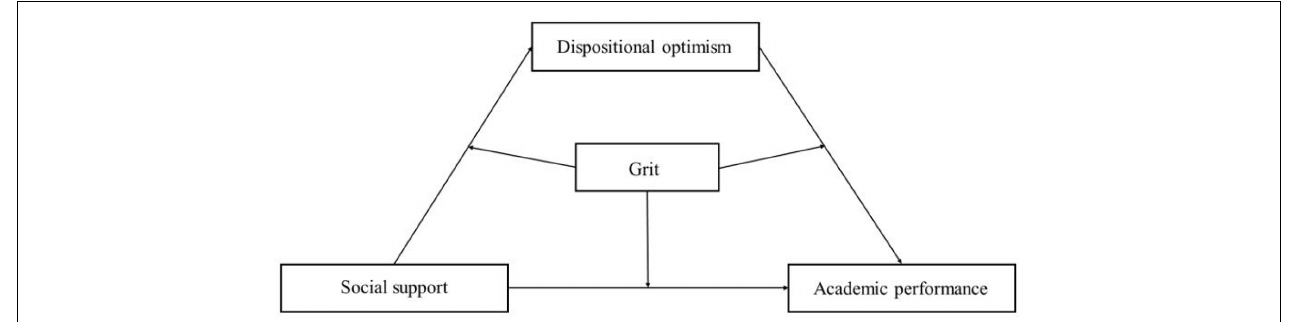
FIGURE 1 | Hypothesized